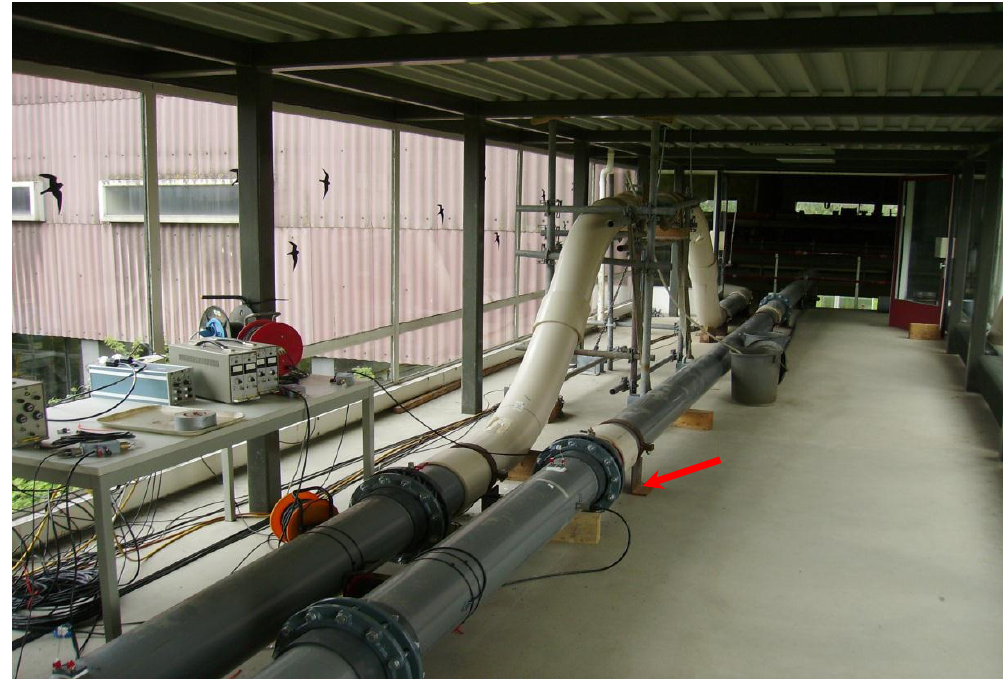
Fig 5. The PVC pipe bridge, its tube-frame support and pressure transducer p